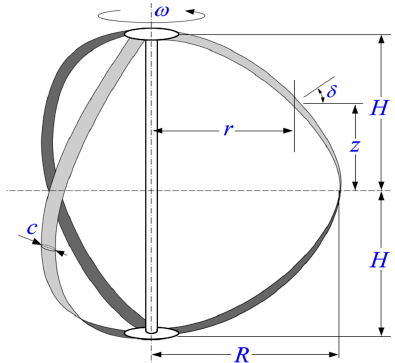
Figure 2. Schematic of a curved, three ‐ blade DT ‐ VAWT.